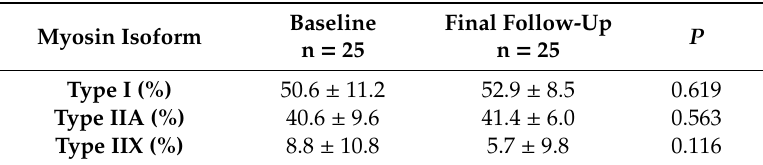
Table 5. Relative proportions of different myosin isoforms in SDS-PAGE at perimenopause and early postmenopause.